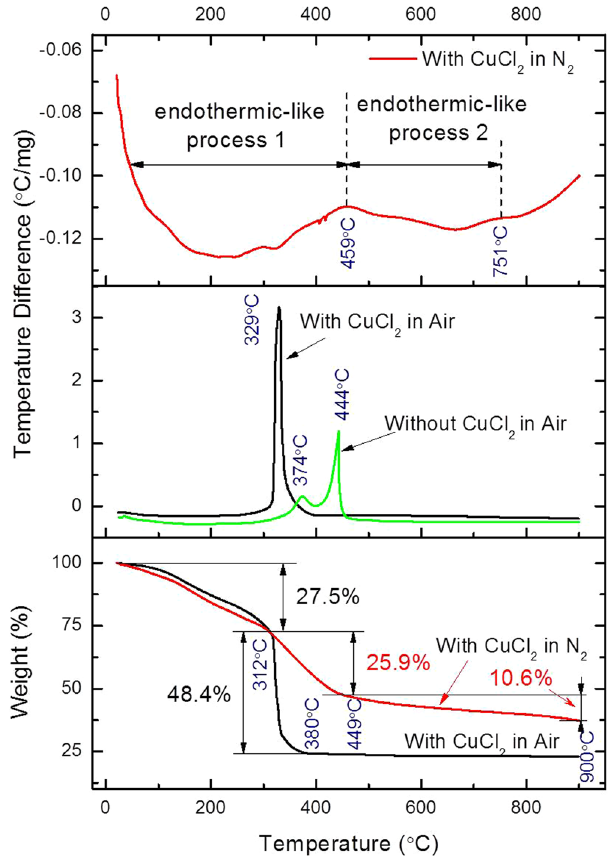
Figure 1. The TG-DTA curves of the xerogel in two atmospheres including air and flowing N 2